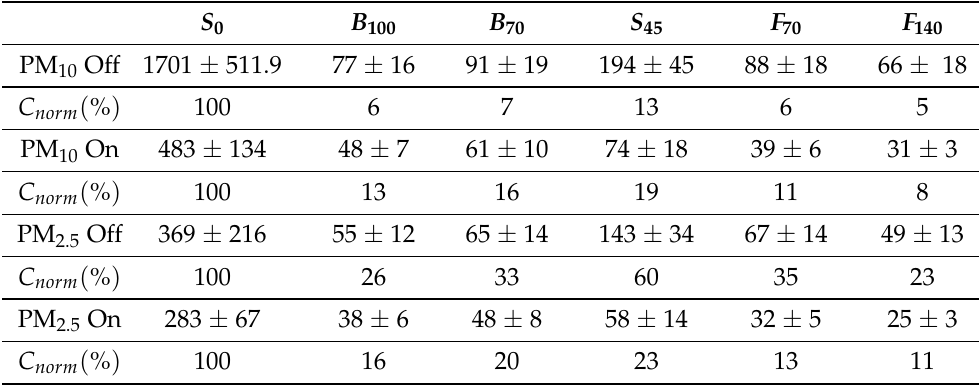
Table A1. Mean and standard deviation concentrations ( µ g m − 3 ) of fine and coarse aerosol concen- trations and normalised concentrations at different distances from the source under ventilation off and on